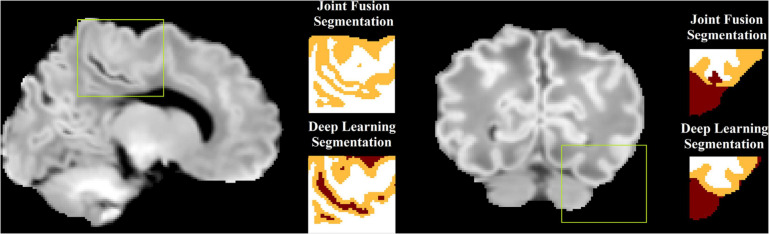
An illustration of mis-segmentation using joint fusion-based multi-atlas tissue segmentation. In the areas with dark WM, the surrounding CSF voxels are often misclassified into WM (left) or the dark WM voxels are misclassified into CSF (right), which becomes corrected using the proposed deep learning approach.